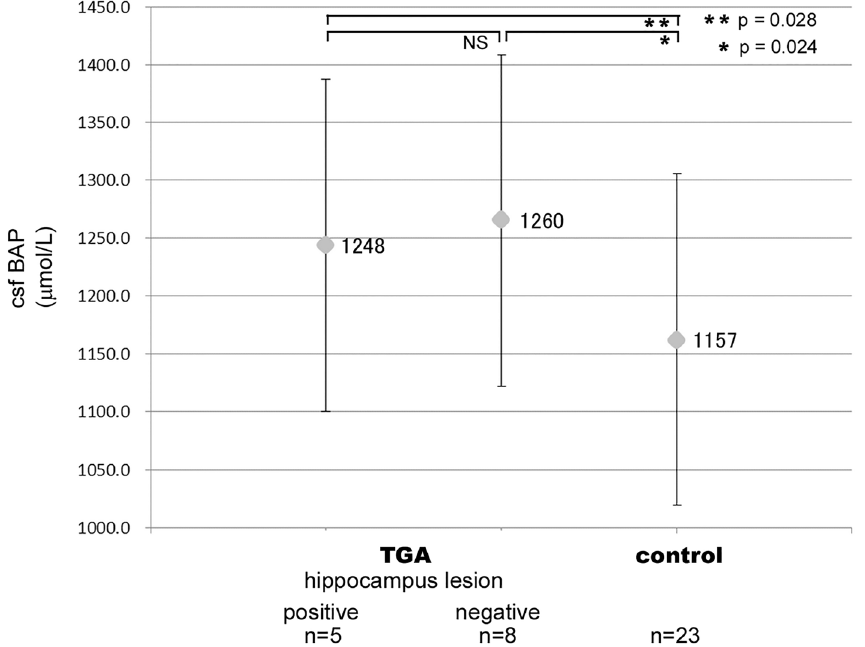
Figure 3. csf BAP in TGA patients and controls. csf cerebrospinal fluid, BAP biological antioxidant potential, TGA transient global amnesia, Hippocampus lesion hippocampus lesion by a diffusion-weighted MRI scan. Statistical analysis was made by the Mann–Whitney U test. csfBAP value in TGA (regardless of MRI hippocampus lesion) was higher than that in the control group (p = 0.024, 0.028). However, there was no difference in csfBAP values between hippocampus lesion-positive and -negative TGA